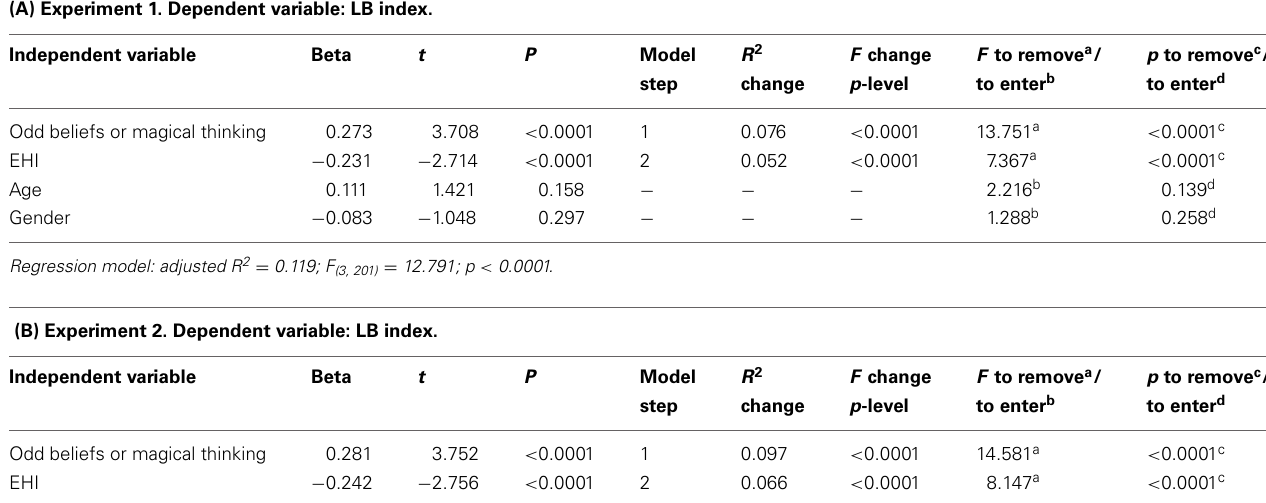
Table 2 | Results of regression models in Experiment 1 (A) and Experiment 2